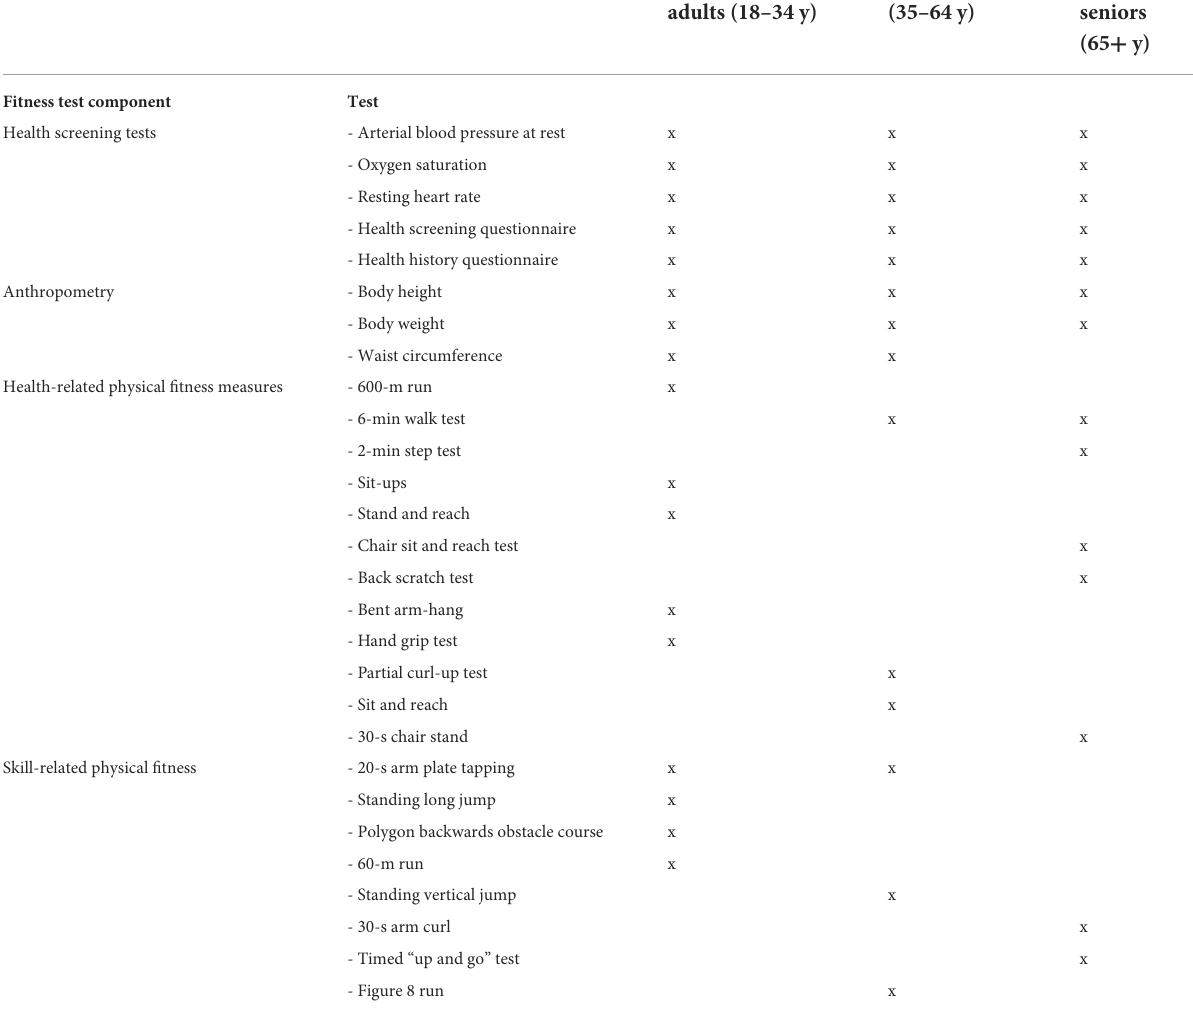
TABLE 1 Fitness test battery components for each age group included in the SLOfit Lifelong community health